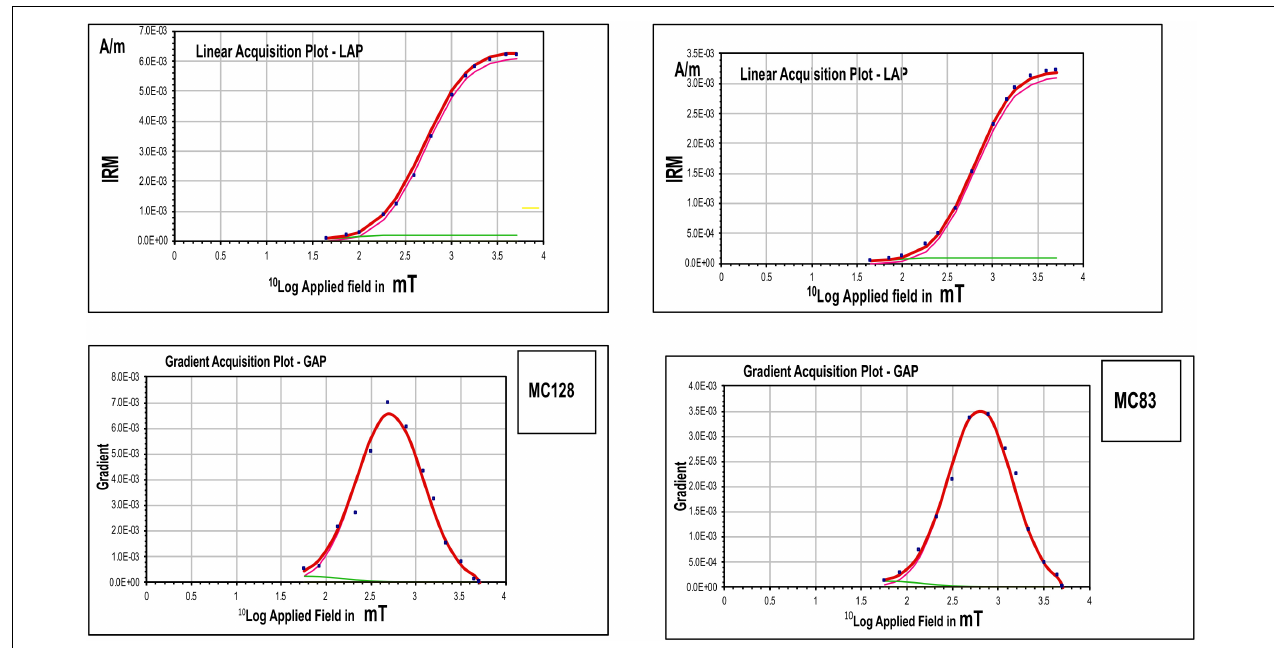
FIGURE 10 | Isothermal remanent magnetization acquisition results showing that the samples are dominated by a high coercivity remanence that saturates by 3.5 T and is probably hematite. There is a minor contribution from a lower coercivity component that is probably